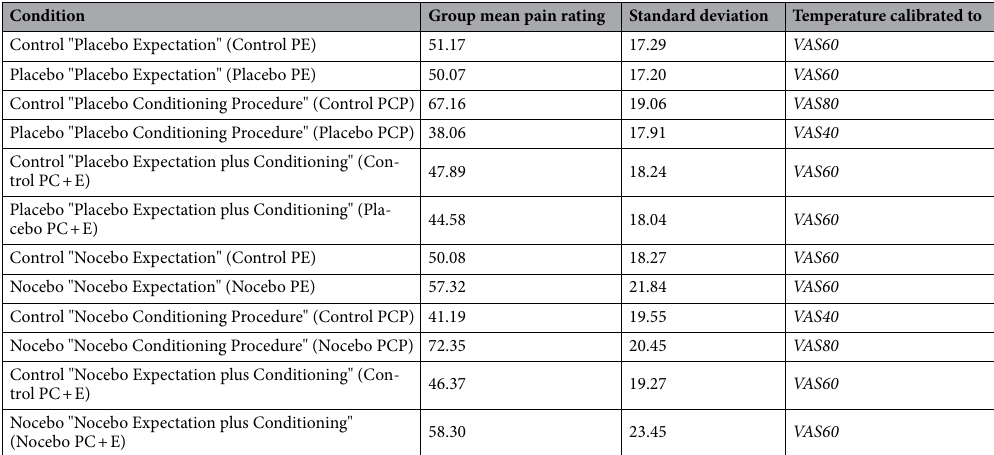
Table 1. Group mean pain rating per condition. Group mean pain ratings and standard deviations for all conditions. Moreover, for each condition it is depicted to what rating the used temperature was calibrated